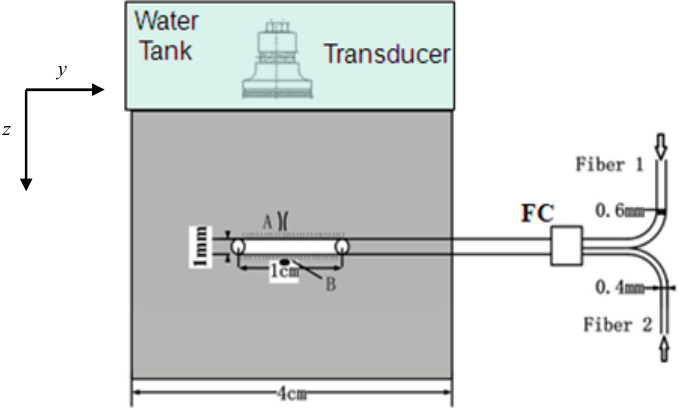
Figure 1. A fiber with a 1.0-cm active tip was placed in the center of the tissue. Both